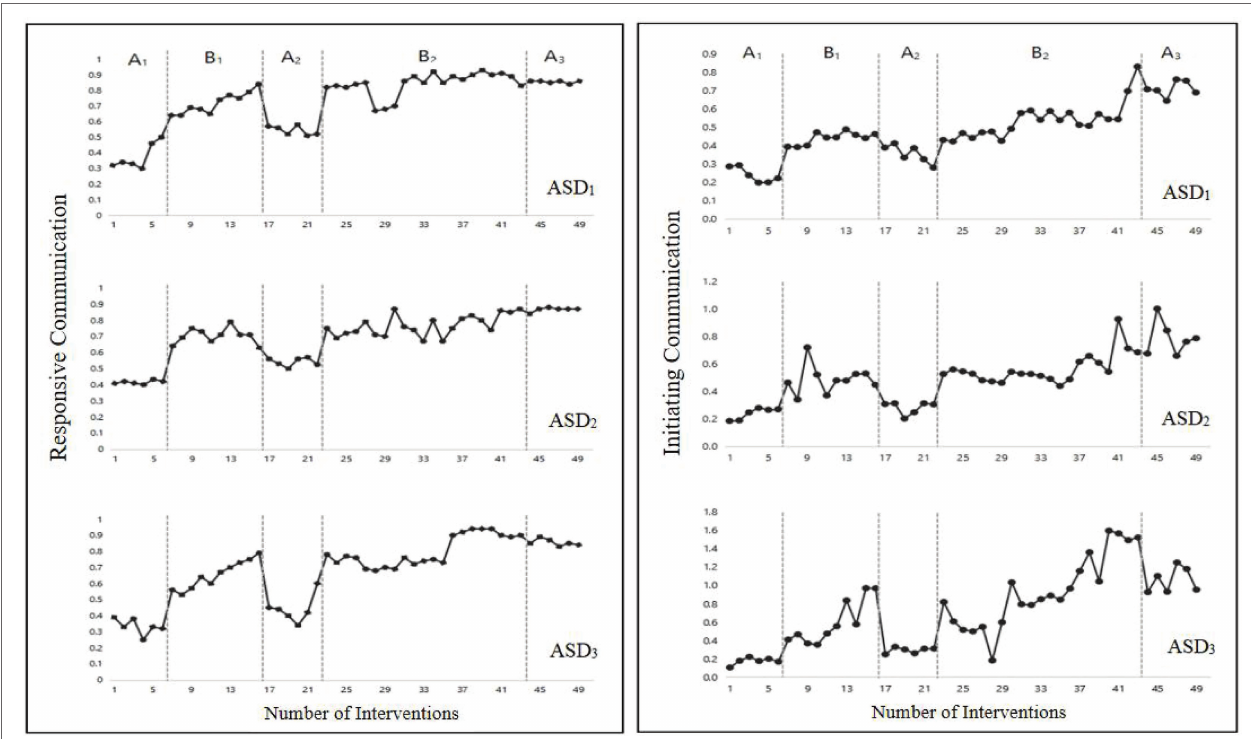
FIGURE 1 | Changes of responsive (left side) and initiating (right side) communication in the five intervention stages (Study